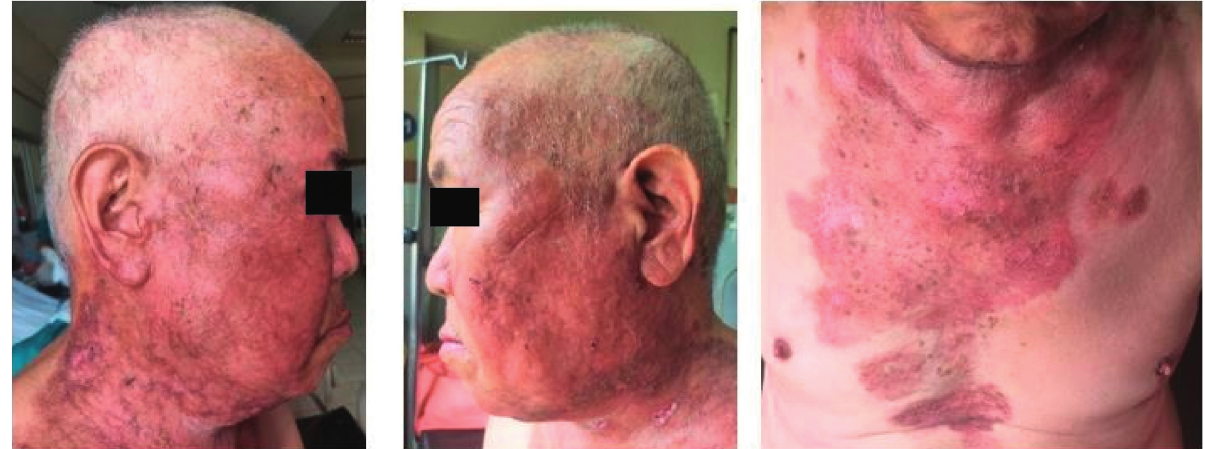
Figure 7: Almost 100% improvement within 4 weeks of commencing antiviral